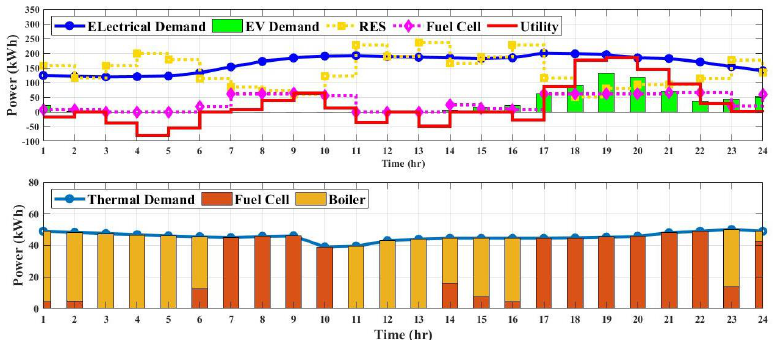
Figure 12. Hybrid energy supply with the FC.